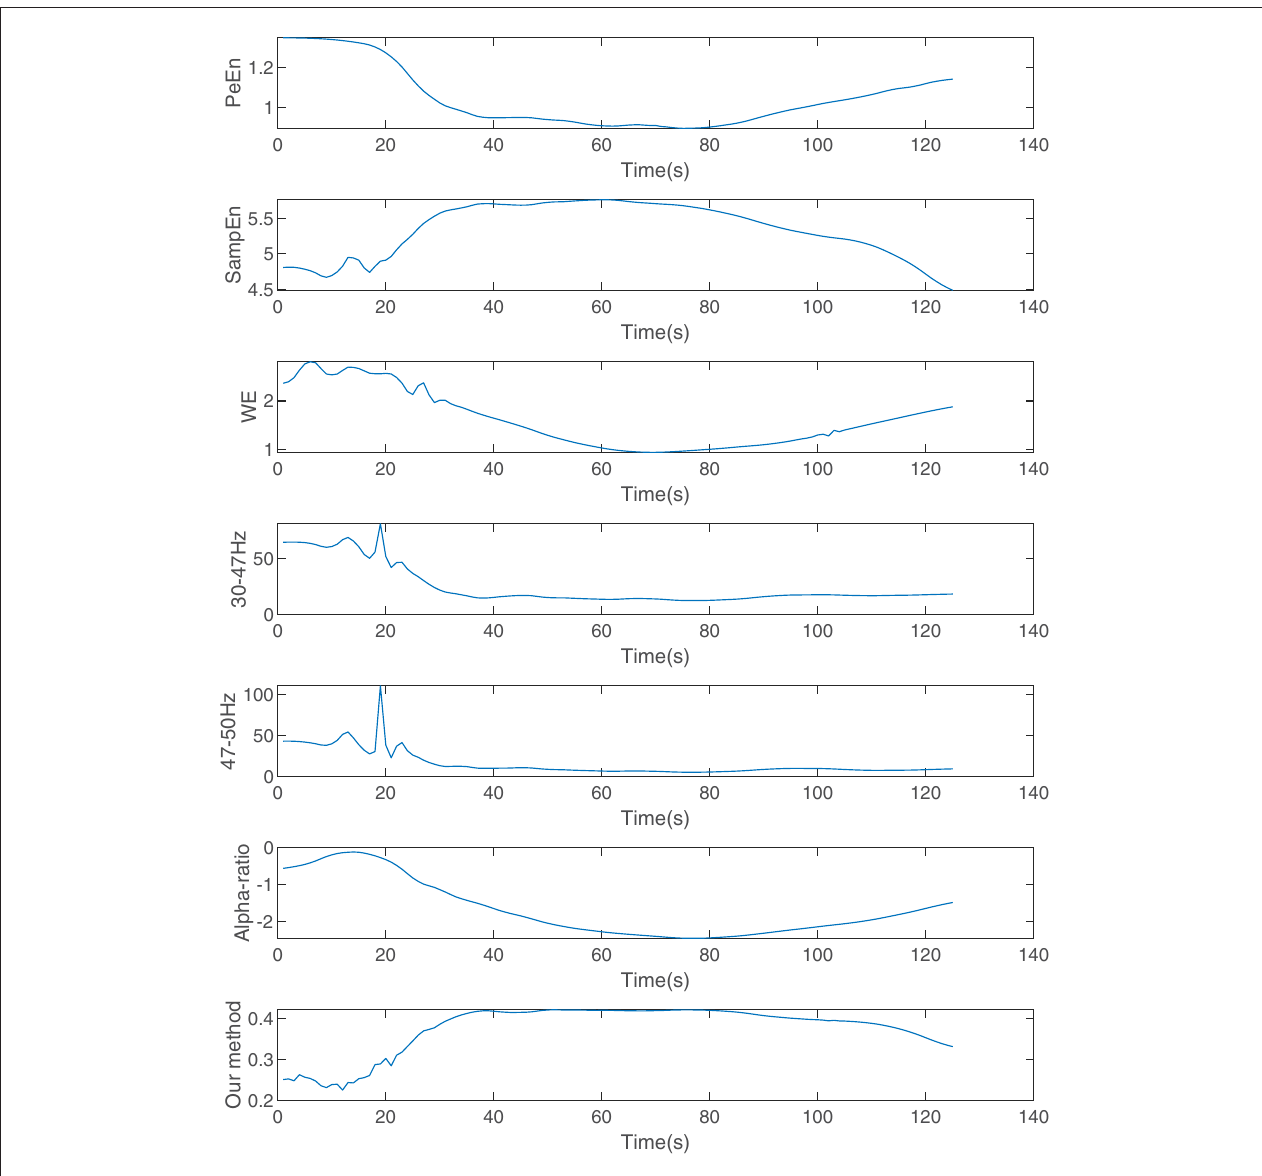
FIGURE 7 | The indices calculated by wavelet entropy, sample entropy, alpha-ratio, the average spectra of 30–47 and 47–50 Hz, permutation entropy, and our method during anesthesia.